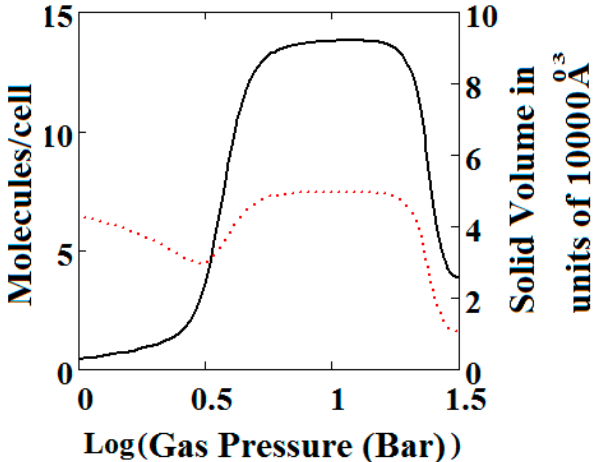
Figure 5. Plot of the behaviour of the methane adsorption in the theory MOF showing two regions of NGA transformation. The dotted red curve on the secondary right axis indicates the NP/LP state of the MOF. The other parameters are T = 285 K, uglp = − 29.1 kJ/mole, ugnp = − 28.69 kJ/mole, J = − 1.66 kJ/mole, Δ = 5.8 kJ/mole, X = 10,000 Å 3 , Y = 50,000 Å 3 . At high gas pressure the MOF is compressed into the NP state. The behaviour shown at high pressure should be almost universal for MOFs. Nm = 10, scale = 0.85, nmaxlp = 4, nmaxnpb = 4 (gradual transformation theory). Compare with Figure 4.